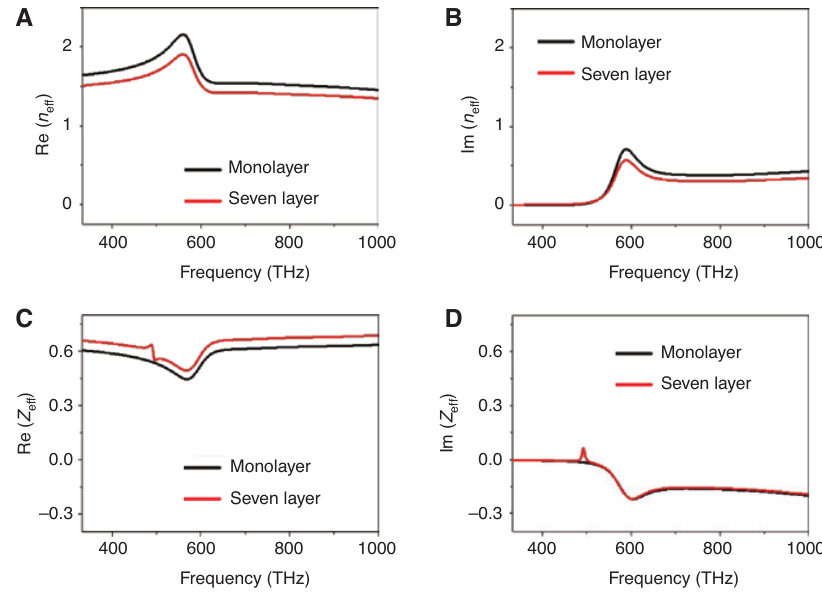
Figure 3: Effective parameters for the homogenized gold nanoparticle monolayer. (A) The real and (B) the imaginary part of the effective refractive index n impedance z of the monolayer (black lines) and seven layers (red lines) of gold eff